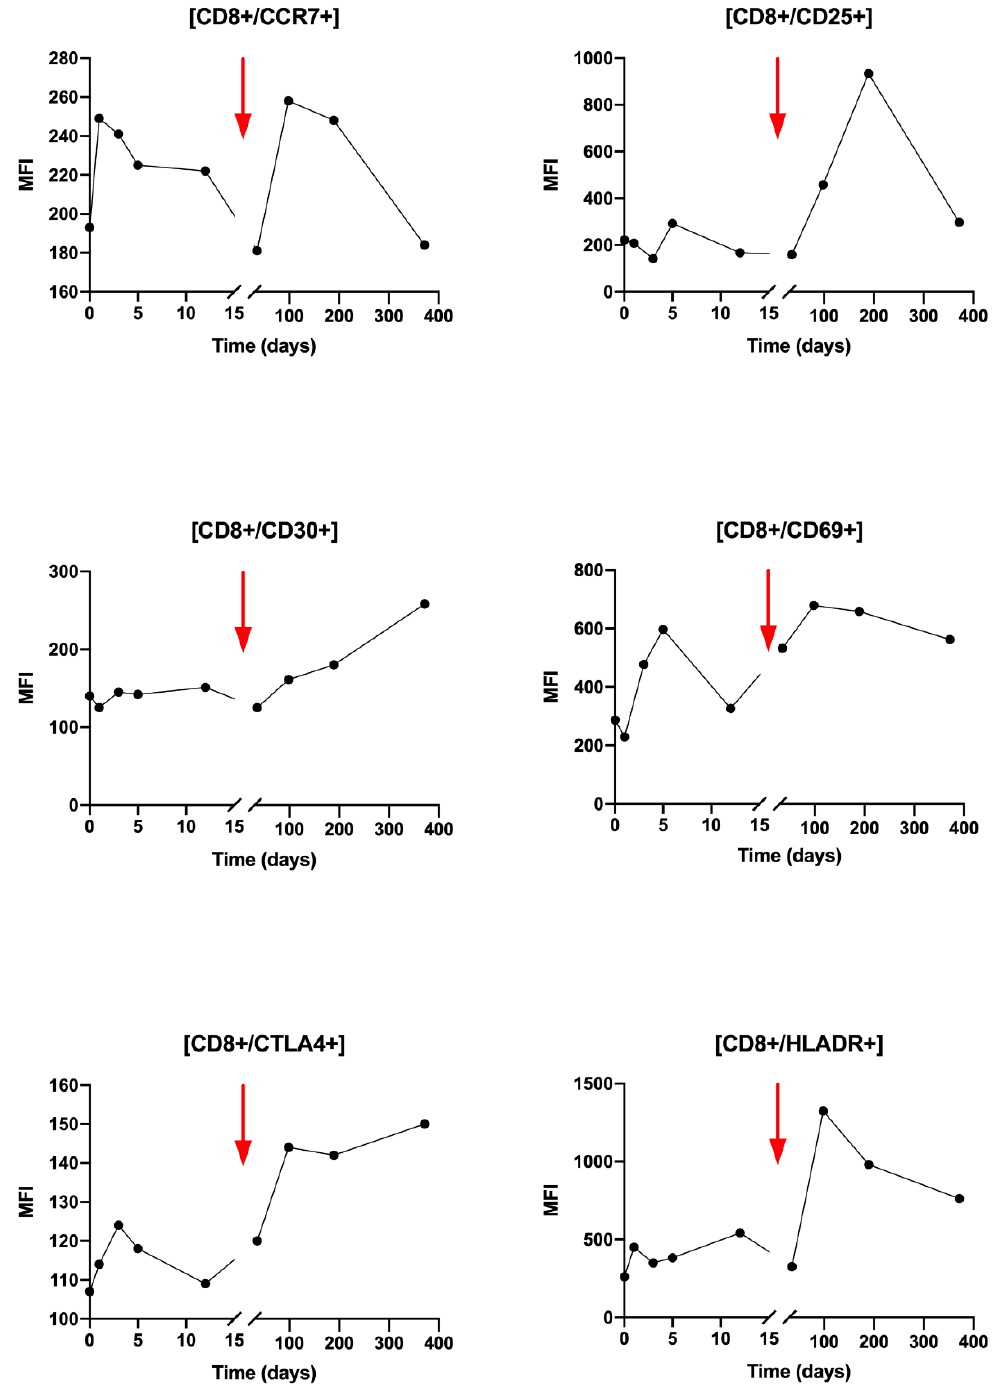
Figure 5. Analysis of CD8 + T lymphocytes activation state by flow cytometry for several activation markers: CCR7, CD25, CD30, CD69, CTLA4, HLADR. Results are presented over time (days) and expressed in median of fluorescence (MFI). The red arrow points the Nivolumab injection timepoint, 90 days after the beginning of the follow up.